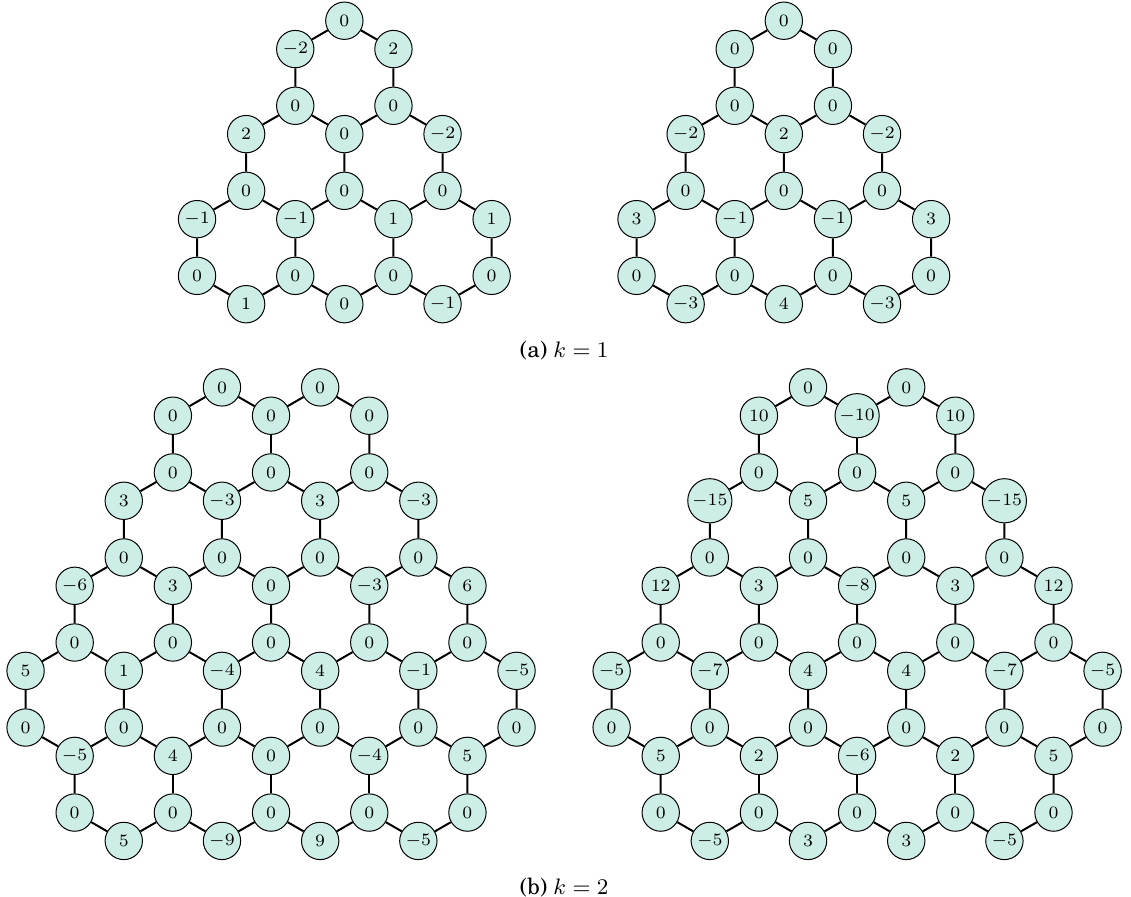
Figure 3: The orthogonal pair ( x , y ) transforming as the E irreducible representation of D of the family H ( k + 2 , k, k, k ) . Unnormalised forms are shown, to give integer